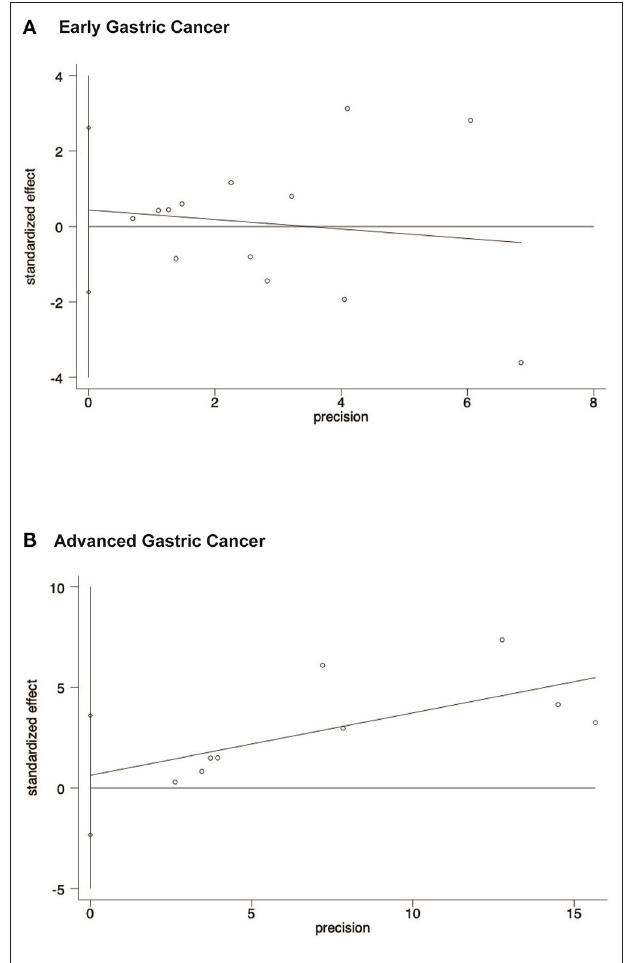
FIGURE 6 | Egger’s test results showing that there is no publication bias of early gastric cancer subgroup and advanced gastric cancer subgroup for overall survival outcomes. (A) Early gastric cancers. (B) Advanced gastric